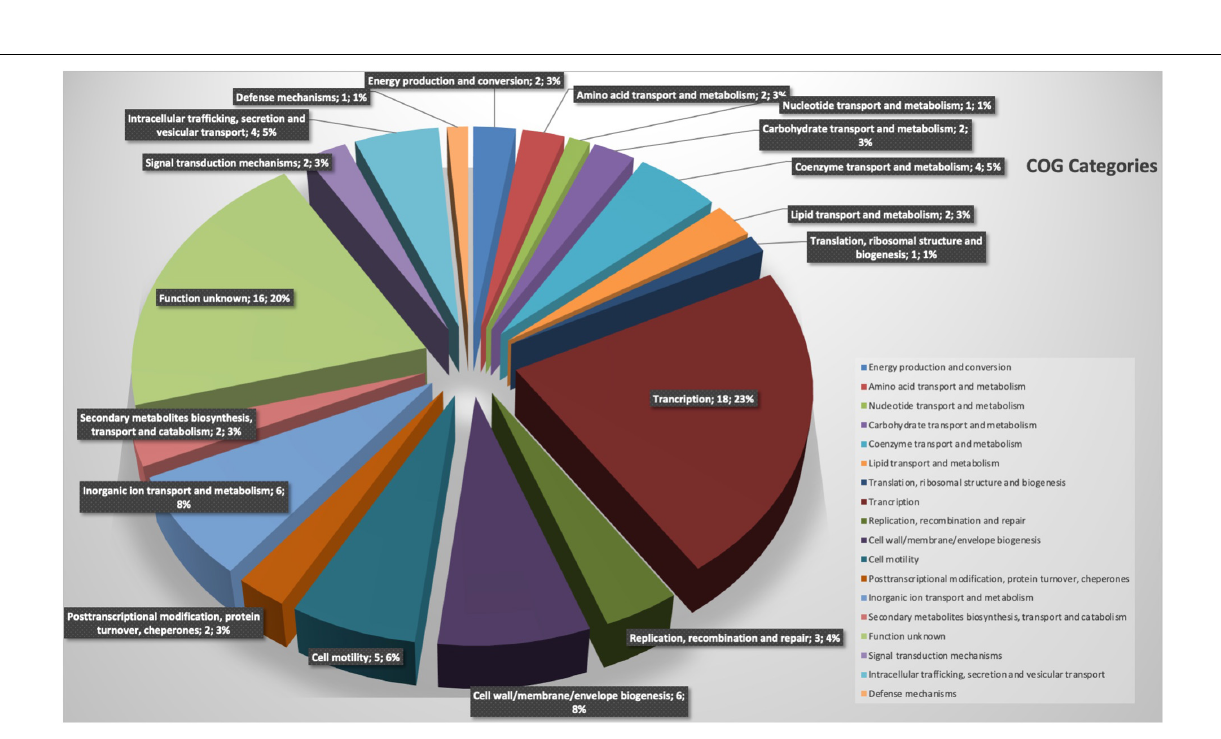
Frontiers in Microbiology |